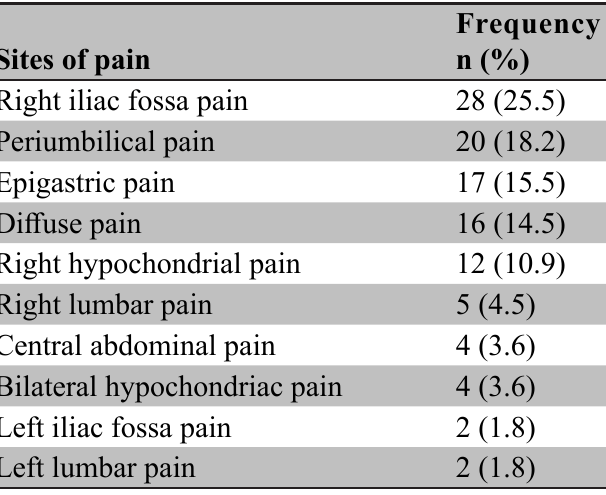
Table 1. Distribution of sites of pain in acute abdomen